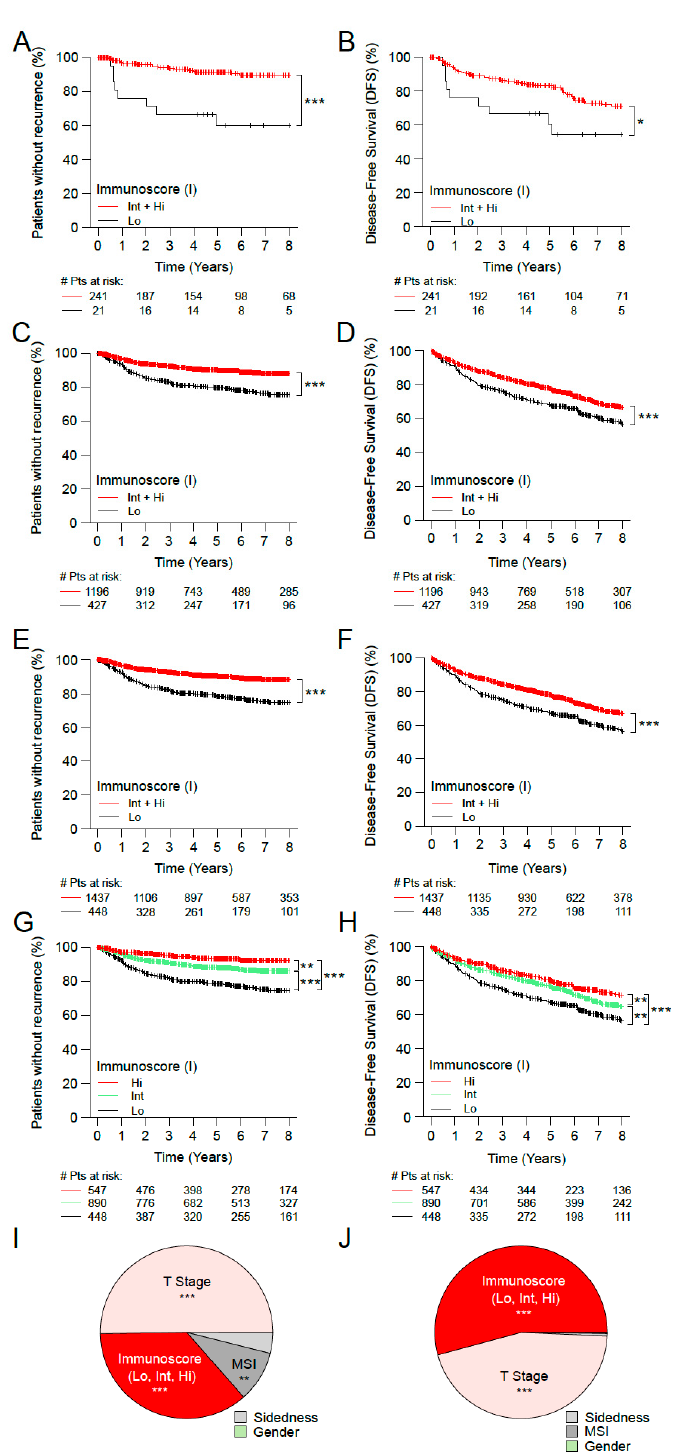
Figure 1. The impact of Immunoscore on the outcome of patients with early-stage (Stage I/II) colon cancer. Kaplan-Meier curves of Immunoscore (I) are shown for TTR ( A,C,E,G ) and DFS ( B,D,F,H ) for patients from cohort 1 ( A,B ), cohort 2 ( C,D ), all patients from cohort 1+2 ( E–H ). ( A–F ) Immunoscore two categories: I Lo (0–25%, black), I Int + Hi (>25–100%, red). ( G,H ) Immunoscore three categories: I Lo (0–25%, black), I Int (>25–70%, green) and I Hi (>70–100%, red). Relative importance of each risk parameter to survival risk for TTR ( I ) and DFS ( J ) using the χ 2 proportion test for clinical parameters and Immunoscore corresponding to panels G and H. Significant logrank p -values are marked as *** p < 0.001, ** 0.001 < p ≤ 0.01, * 0.01 < p ≤ 0.05.